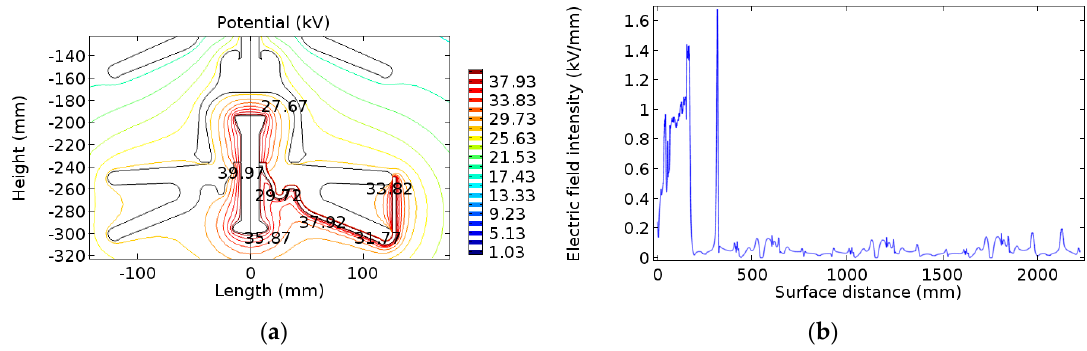
Figure 21. Simulation results of Bridge 1: ( a ) equipotential line distribution; ( b ) electric field distribution along insulator string.